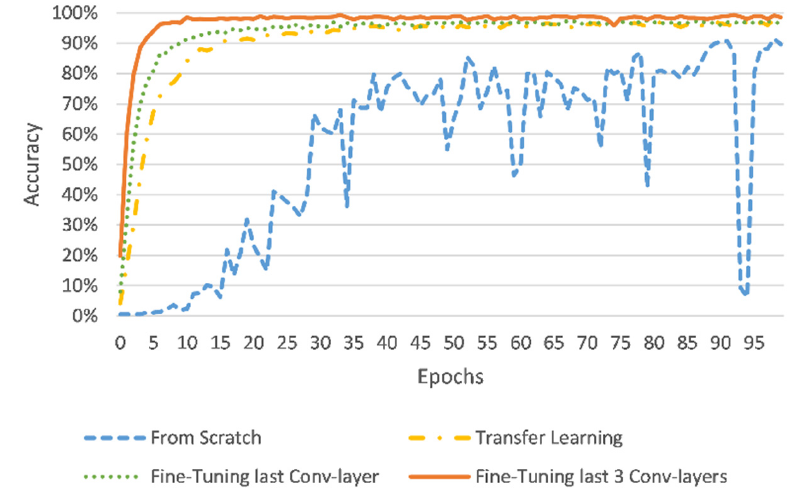
Figure 5. Validation accuracies of the proposed model in different settings.